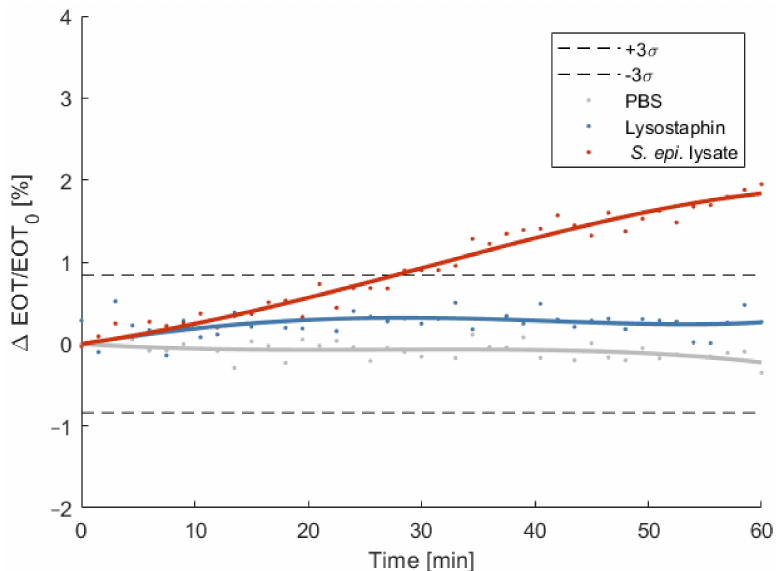
Figure 10. Relative effective optical thickness (EOT) shift measured on a PSi membrane for 1 h in PBS (grey), in a lysostaphin suspension (blue) and in a S. epidermidis lysate (red). The bacterial lysate is detected after 30